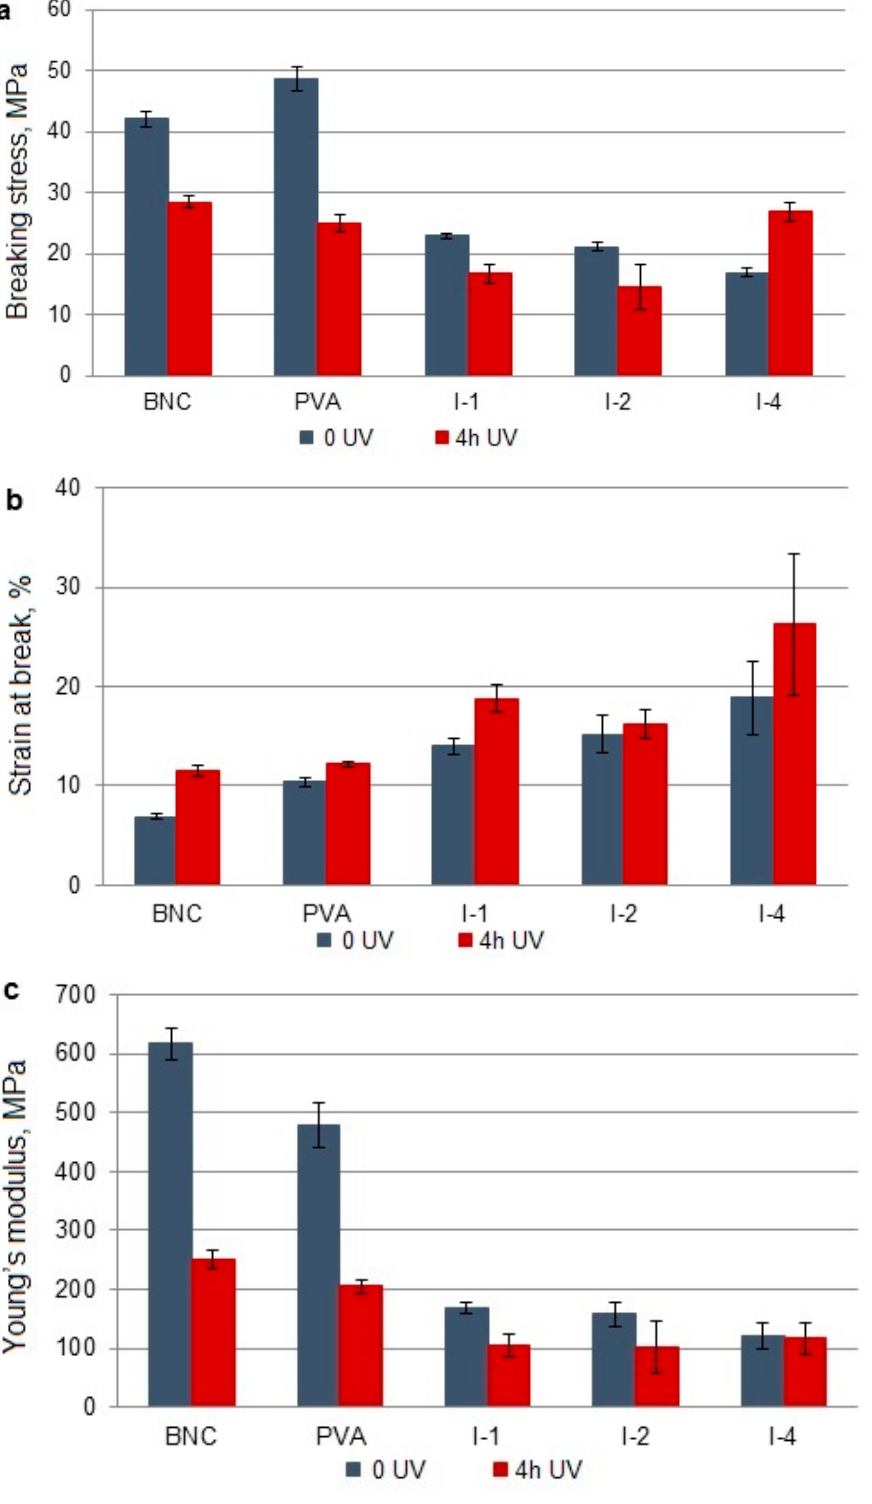
Figure 4. Mechanical properties of BNC, PVA, and their blends obtained by ex situ/impregnation before and after UV irradiation: breaking stress ( a ), strain at break ( b ), and Young’s modulus ( c ).